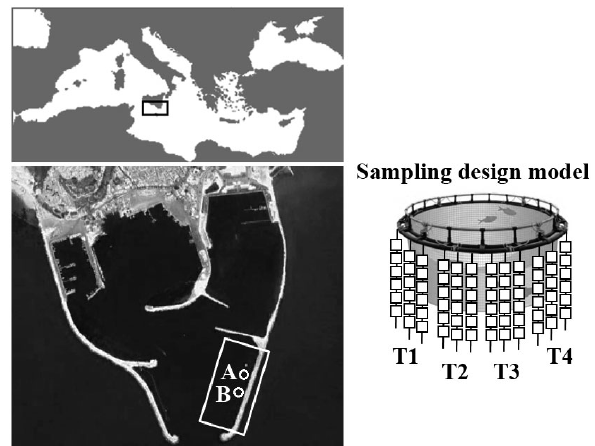
Fig. 1. Study area, Licata Harbour (northern side of Sicily Strait), showing the 2 cages (A and B; 100 m apart), and sampling design (each panel is double faced). Panels were collected every 3 mo (n = 18). T1: September 2014;